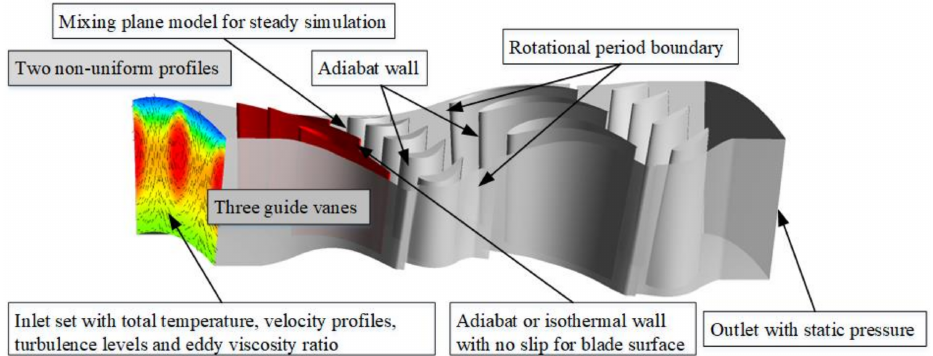
Figure 1. Computational domains and boundary conditions.